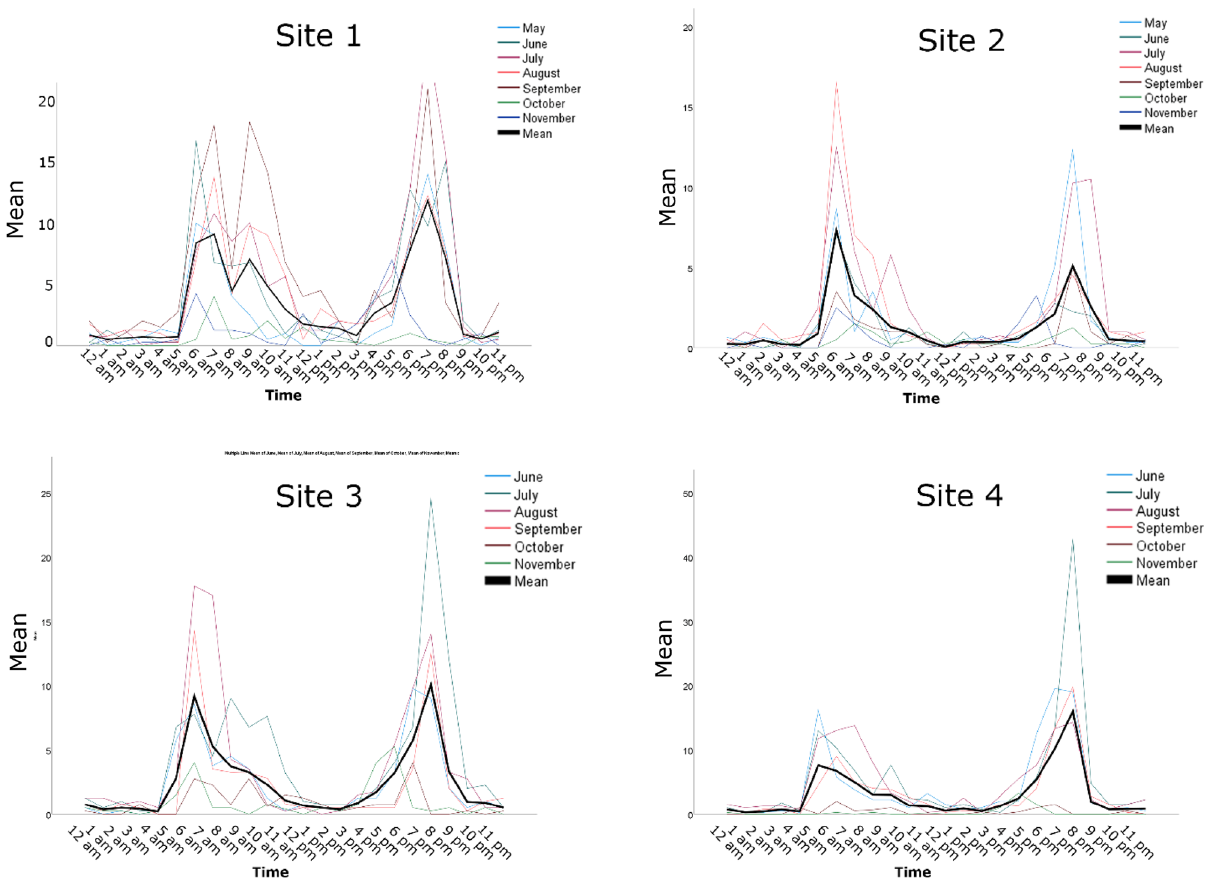
Figure 1. Diel activity patterns for Ae. aegypti populations at each of the 4 sampling sites in Miami, Florida. “Mean” on the graphs represent the mean number of female Ae. aegypti mosquitoes captured per trap/hour. The thick black line is the mean number of Ae. aegypti female mosquitoes captured per trap/hour throughout the study period from May to November